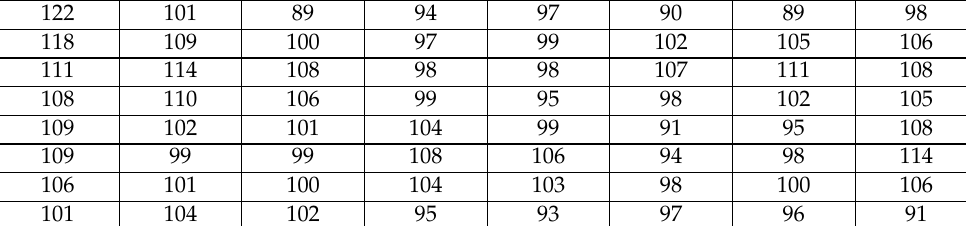
Table 3. Pixels values for a MCU after performing level shift.